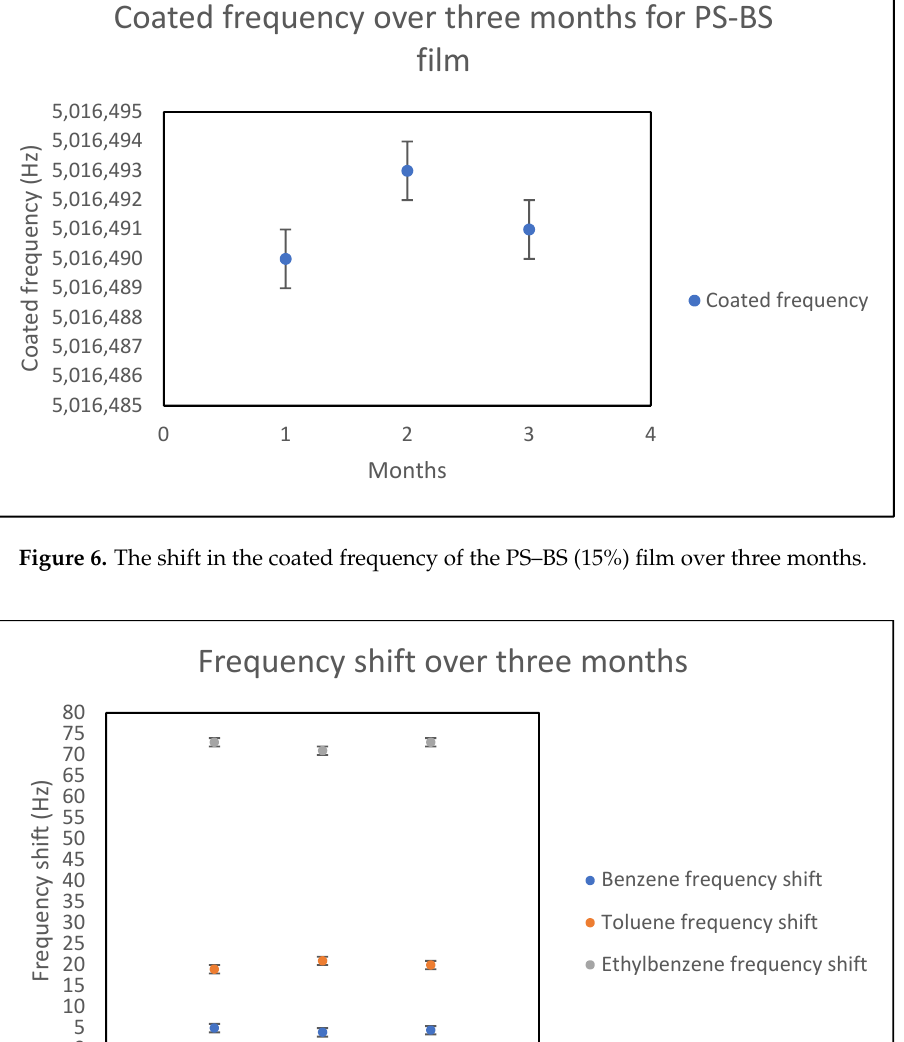
Sensors 2021 , 21 , x FOR PEER REVIEW